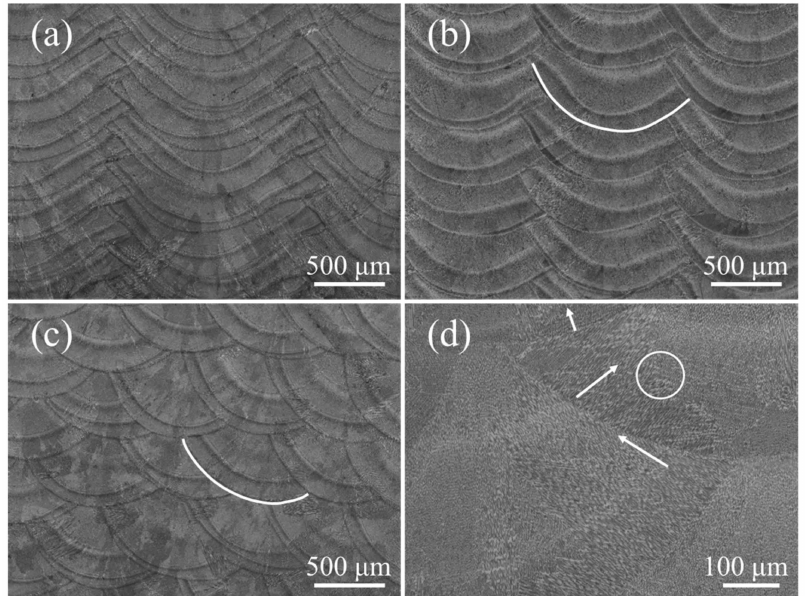
Figure 10. The microstructure with different track offset: ( a ) 1.4 mm; ( b ) 1 mm; ( c , d ) 0.6